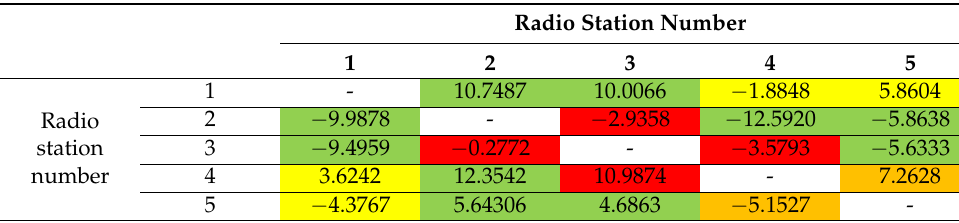
Table 2. Average TDoA error (in microseconds) for individual pairs of radio stations. Cell background colors are explained in text below table.